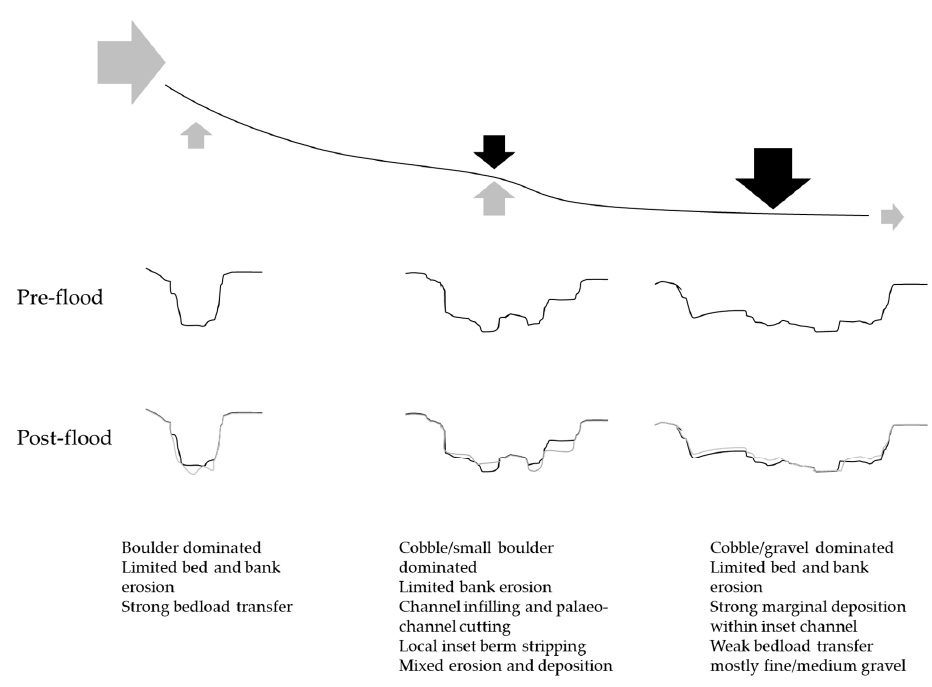
Figure 11. A model of torrent channel response to a contemporary temperate climate flood